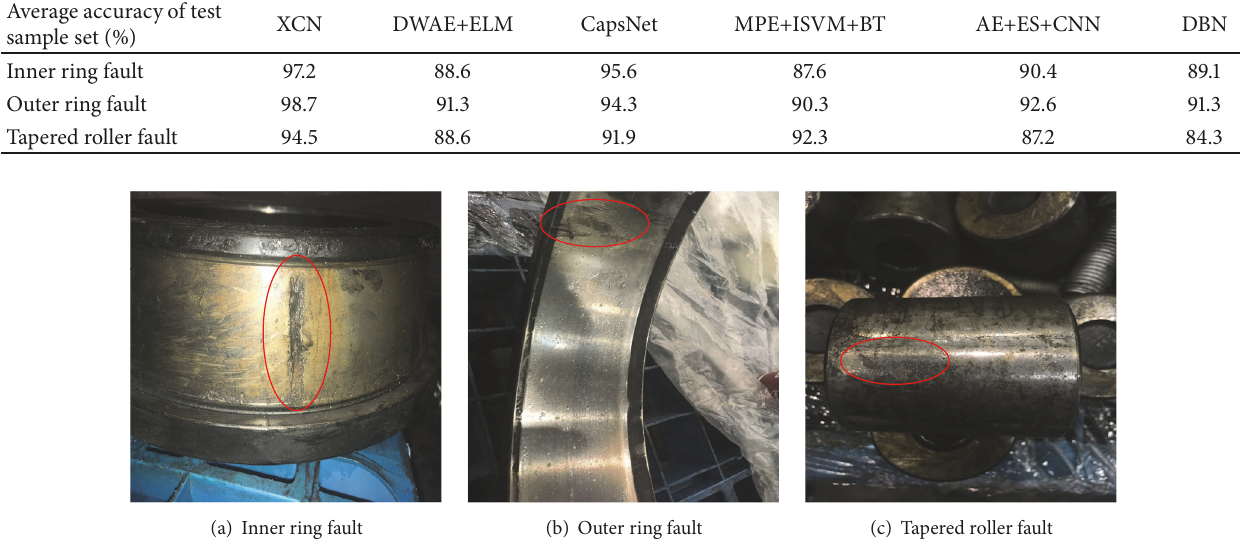
Figure 16: Fault types of wind turbine gearbox under actual working condition.